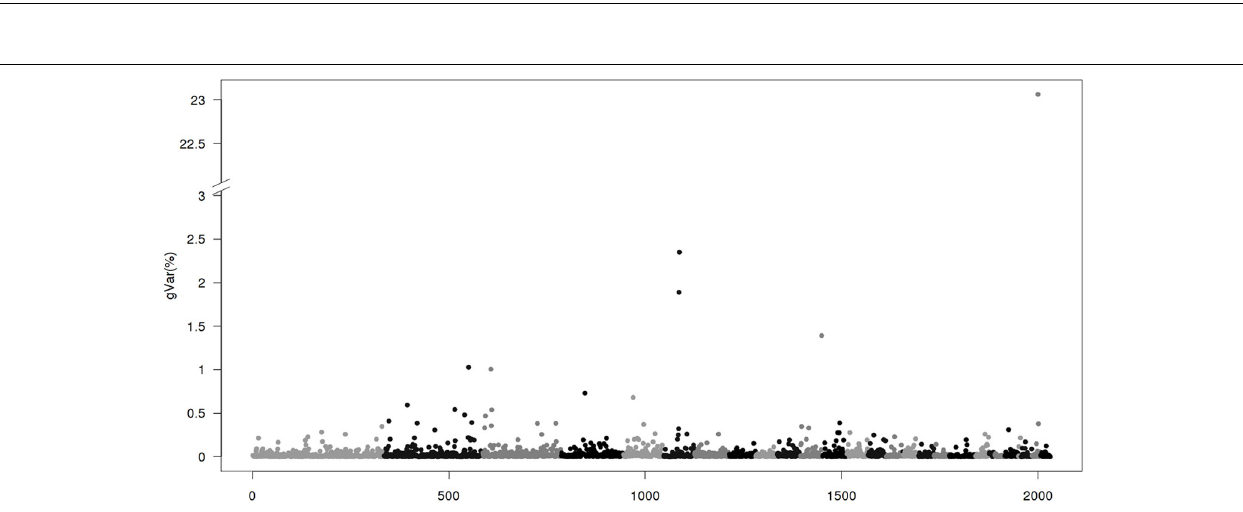
FIGURE 4 | Proportion of genetic variance of 20-SNP region using BayesB with π = 0 . 9 implemented by GenSel. The x-axis represents region location of 20 SNPs. The y-axis represents the proportion of genetic variance of each region.